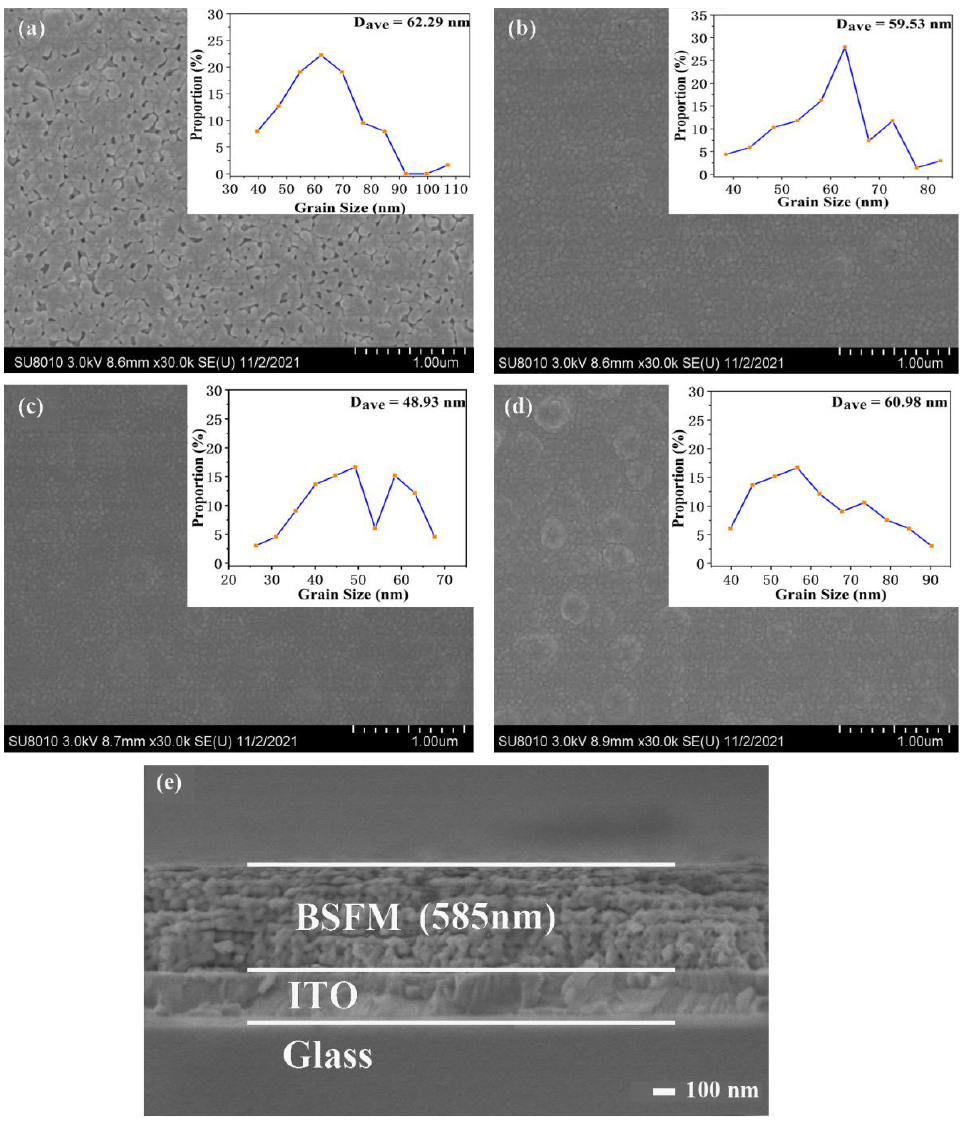
Figure 3. SEM images of the surface morphological features of the BSFM films: ( a ) x = 0 mol%; ( b ) x = 2 mol%; ( c ) x = 4 mol%; ( d ) x = 6 mol%, and ( e ) the cross-sectional image of the BSFMx = 0.06 film. The insets show the distribution of crystal grain size and the average grain diameter (D ave ).